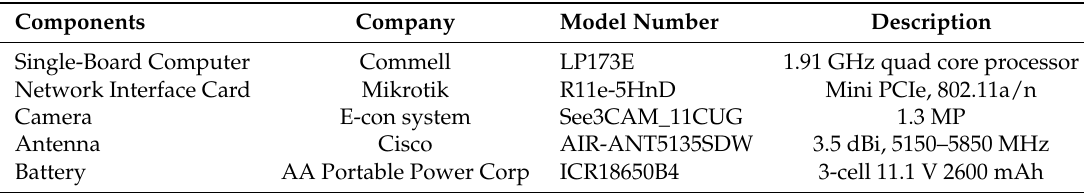
Figure 22. Hardware-in-the-loop simulation (HILS) : Payload. GCS: ground control station. Table 7. Hardware components in